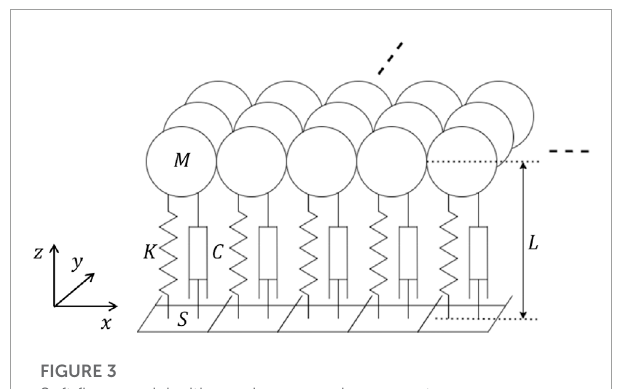
FIGURE 3 Soft floor model with a spring-mass-damper